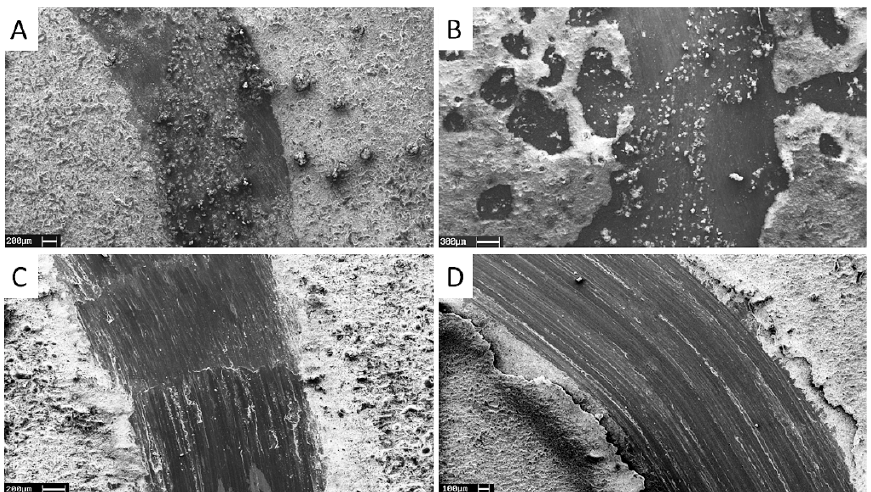
Figure 9. Stereomicroscope images of the surface of the samples after tribocorrosion test ( A ) PEO-Si; and ( B ) PEO-P; and standard wear tests ( C ) PEO-Si; and ( D ) PEO-P.